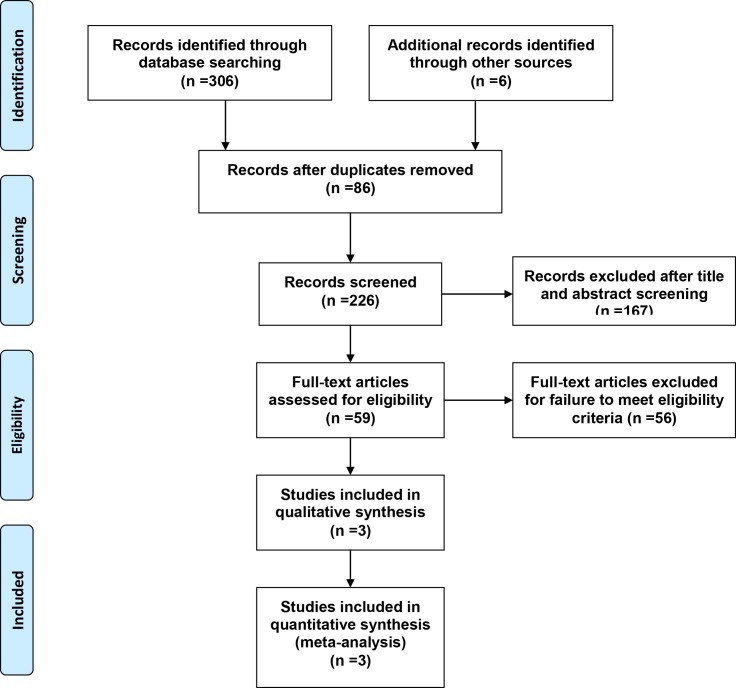
Review flow diagram.